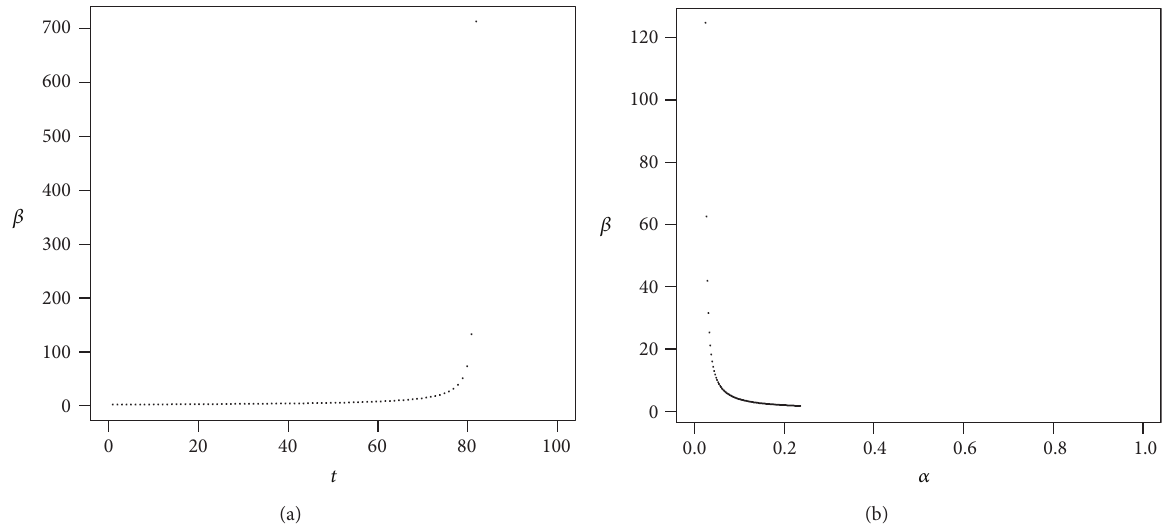
Figure 9: High volatility of returns (breakeven). The plot shows 𝛽 as a function of 𝑡 with 𝛼 = 50 % (a) and 𝛽 as a function of 𝛼 with 𝑡 = 40 (b). Parameters are 𝑟 = 4 %, 𝜇 = 20.5 %, 𝜎 = 75 %, ] = 3.1 %, and 𝛾 = 10 %.